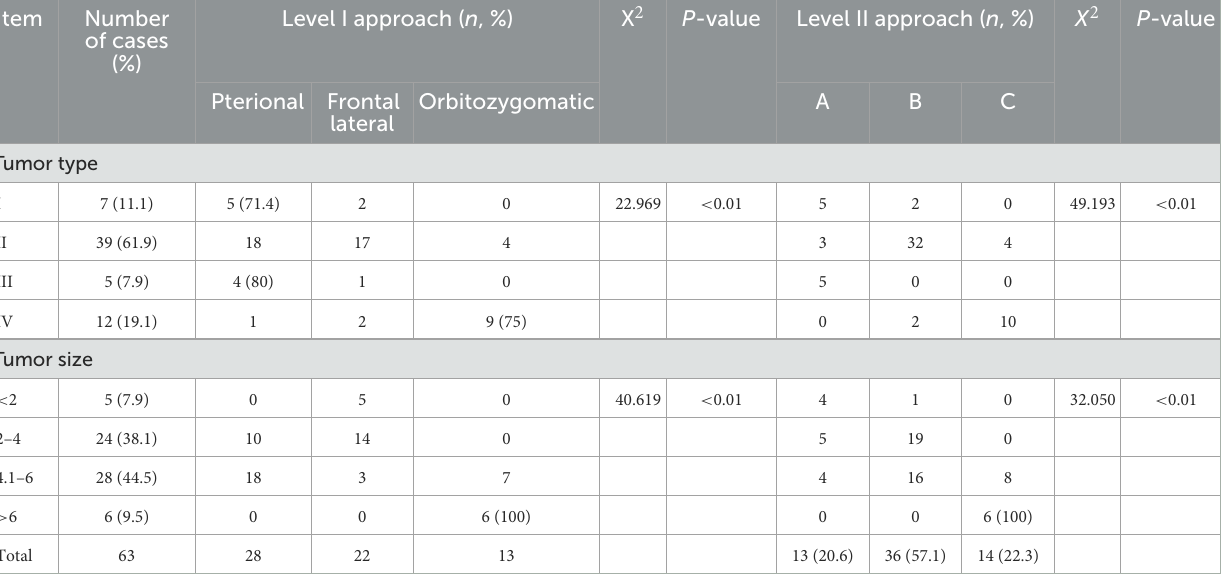
TABLE 3 Selection and comparison of surgical approaches for 63 cases of